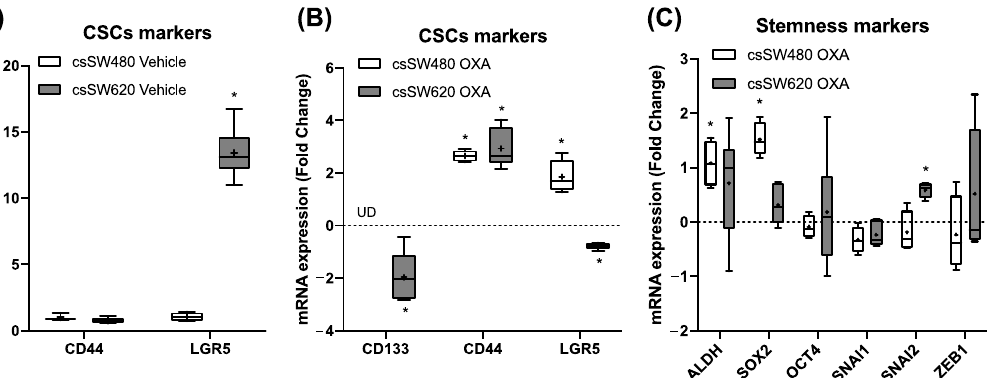
Figure 3. Cancer Stem Cell (CSC) marker mRNA expression after 96 h of vehicle (0.1% DMSO) ( A ) or oxaliplatin 5 µM ( B ) treatment in SW480 and SW620 tumourspheres. Stemness marker mRNA expression after 96 h of oxaliplatin treatment ( C ) in SW480 and SW620 tumourspheres. Each box represents the interquartile range (25th to 75th percentiles), the central horizontal line is the median value, and the whiskers represent the minimum and the maximum values ( n ≥ 4). Student’s test or Mann–Whitney test were performed to determine the significance between the experimental groups. Statistical significance was set at * p < 0.05. UD: Undetected.